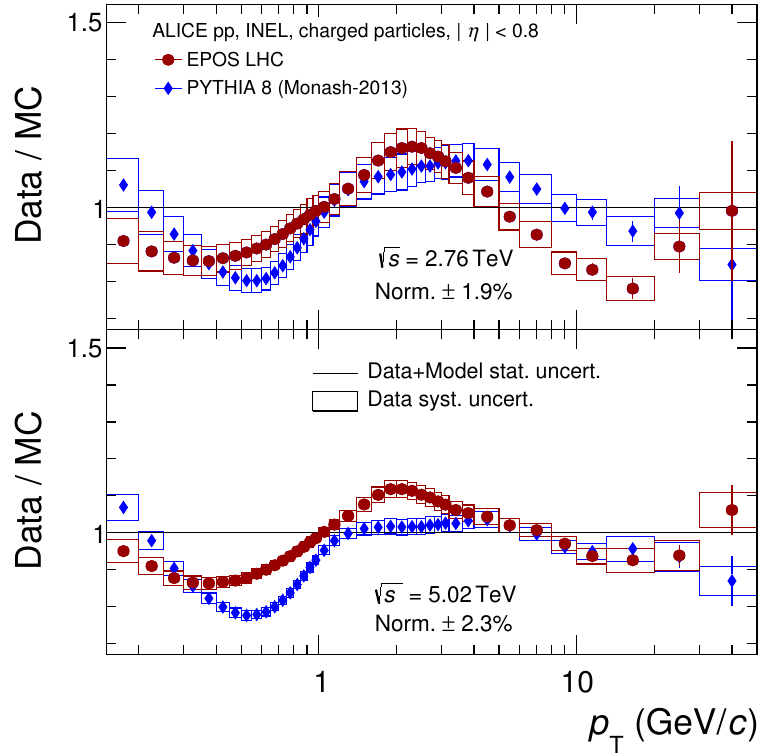
Figure 4 . Comparison of the charged-particle transverse momentum spectra measured in pp collisions to PYTHIA 8 (Monash-2013 tune) [31, 32] and EPOS [53] model calculations at 2.76 (top) and 5.02 TeV (bottom). The statistical uncertainties of the data and model calculations are added in quadrature. The boxes represent systematic uncertainties of the